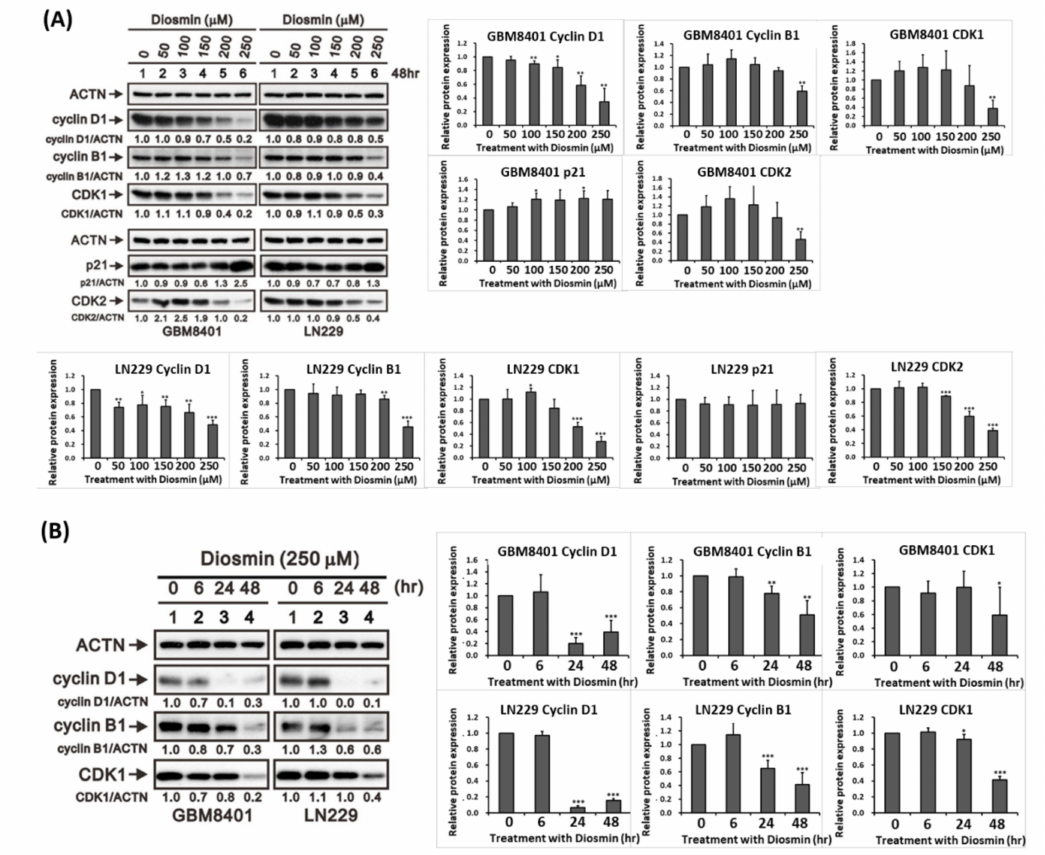
Figure 3. Diosmin induces G1 phase arrest associated with downregulation of cyclin B1, D1, and CDK1. ( A ) Concentration- responsive analysis of cyclin D1, cyclin B1, CDK1, p21, and CDK2 in GBM8401 and LN229 cells ( B ) Time-course analysis of cyclin D1, cyclin B1, and CDK1 in GBM8401 and LN229 cells treated with 250 µ M diosmin. The quantification of abovementioned proteins relative to ACTN was shown in the right panel ( n = 3). * p < 0.05, ** p < 0.01, and *** p < 0.001 vs. control